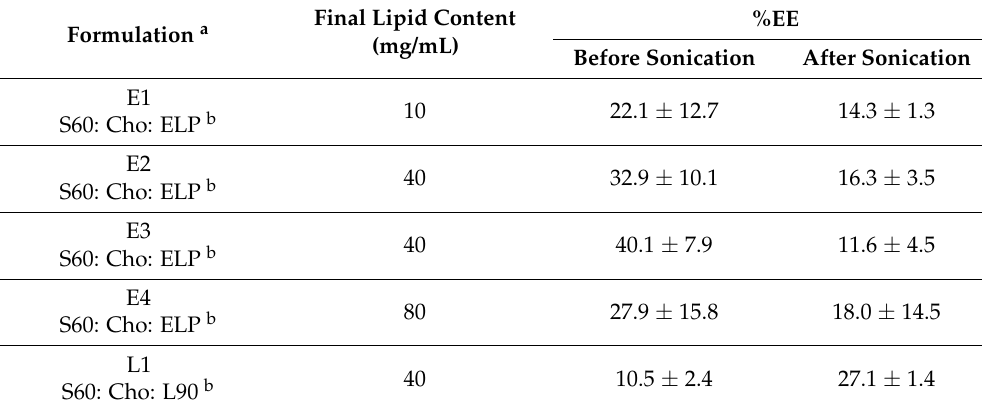
Table 2. Final lipid content (mg/mL) and entrapment efficiency (%EE) of methylene blue-loaded niosomal